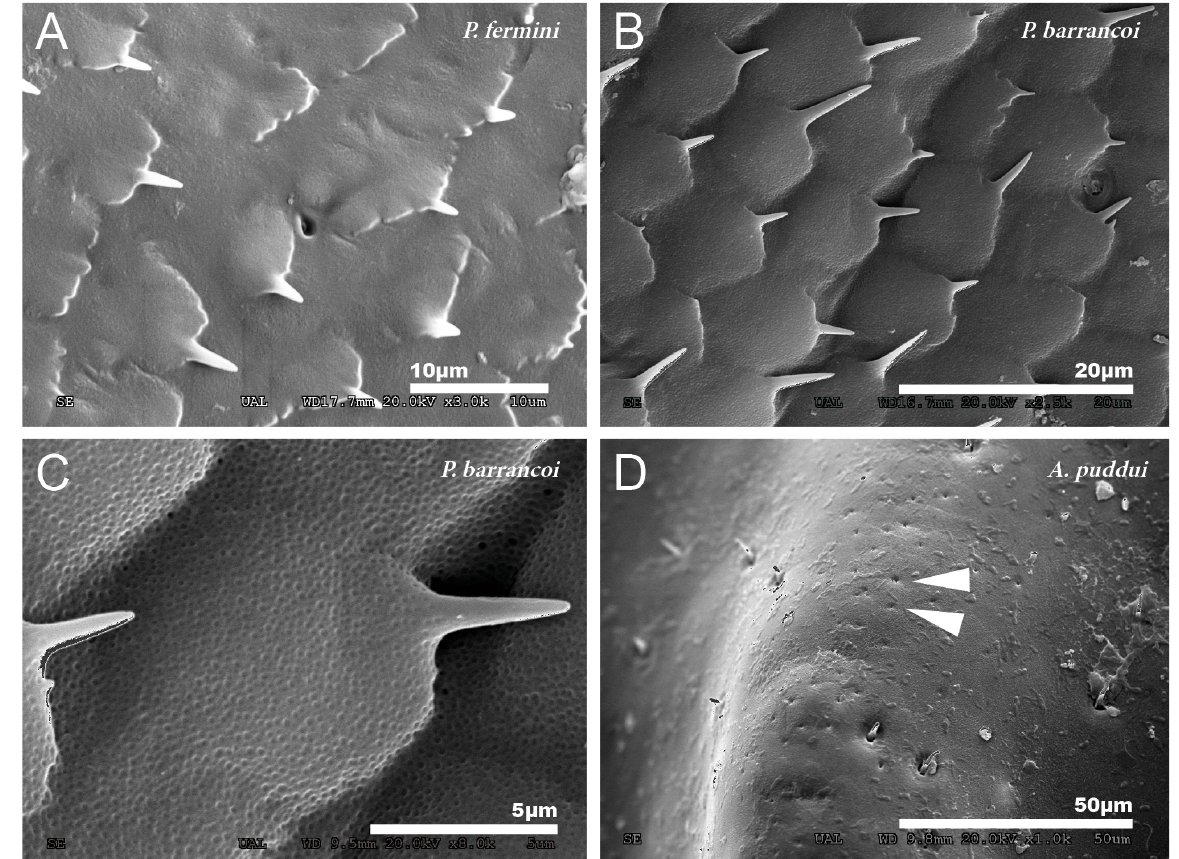
Figure 4. Detailed cuticular study of the dorsal side of the tegmina. Reticulum of imbricate hexagonal scales observed in P. fermini ( A ) and P. barrancoi ( B ). Most of these scales bear a spine distally, and scattered pores are also present. Dotted surface observed on the surface of the tegmina of P. barrancoi ( C ), almost as smooth as in A. sardoa . ( D ) Aligned pores observed in A. puddui . Arrowheads indicate the presence of pores.